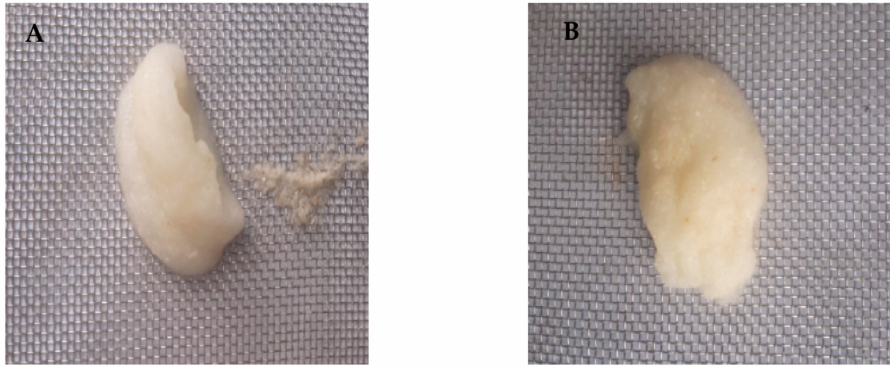
Figure 3. OD samples; ( A ) 75% NaCl and 4:1; ( B ) at 75% NaCl and 8:1.